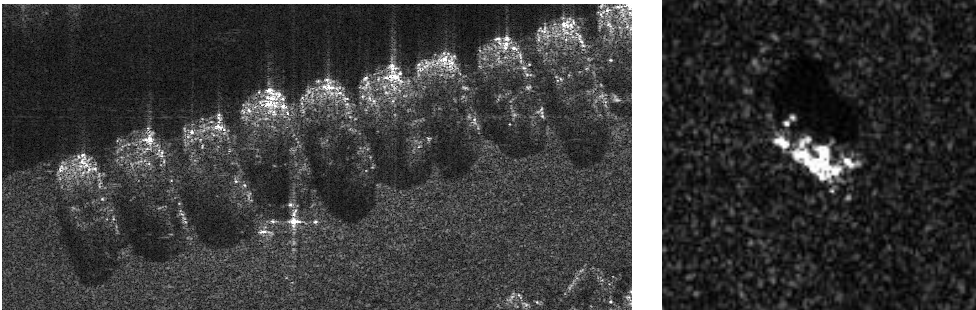
Figure 1. Comparison of civilian cars imaged by Bright Spark [7] ( left ) and a T-72 main battle tank as seen in MSTAR [5] ( right